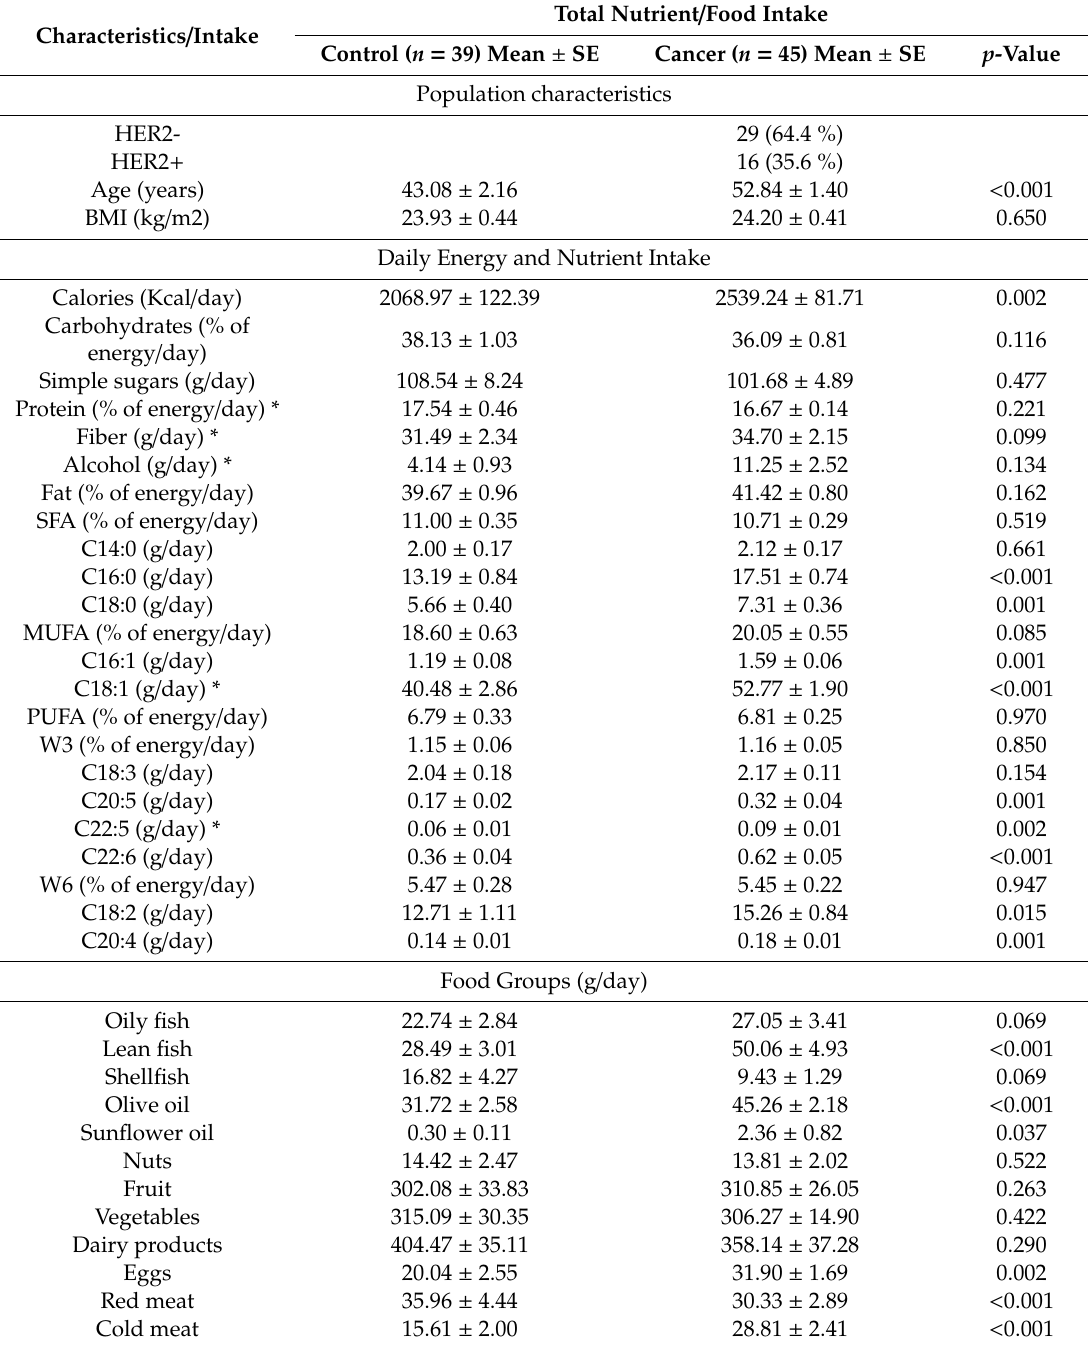
Table 1. Nutrients and food intake in cancer and control